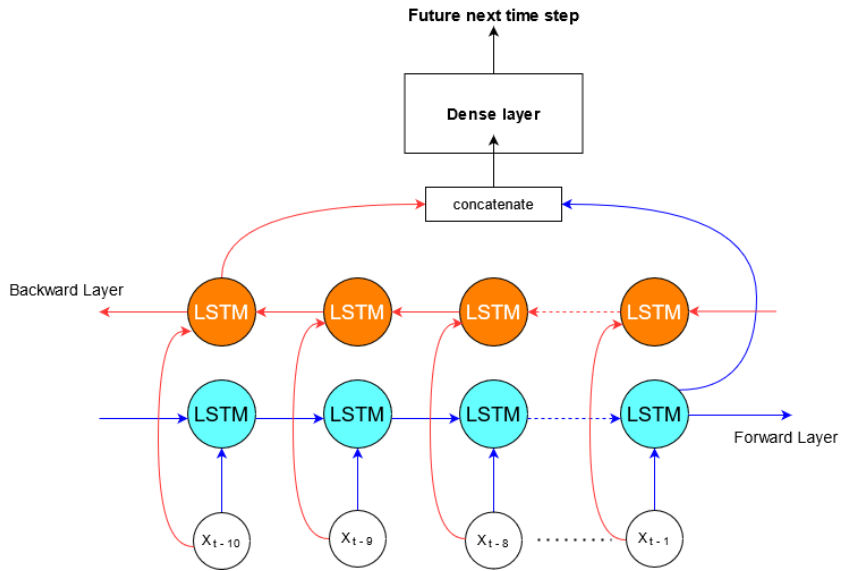
Figure 3. Proposed bidirectional LSTM network